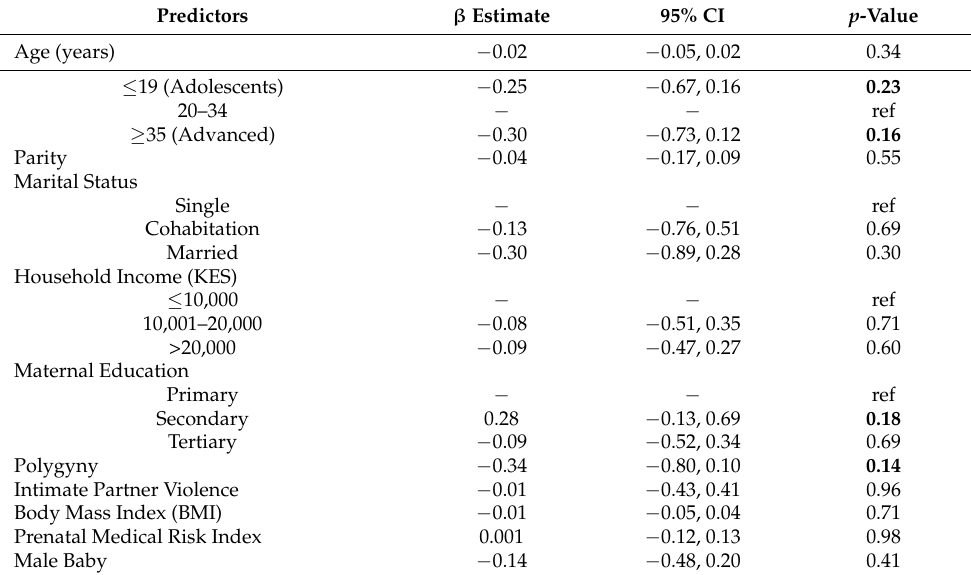
Table A4. Results of bivariate analysis between socio-demographic predictors and sum of hair cortisol and cortisone